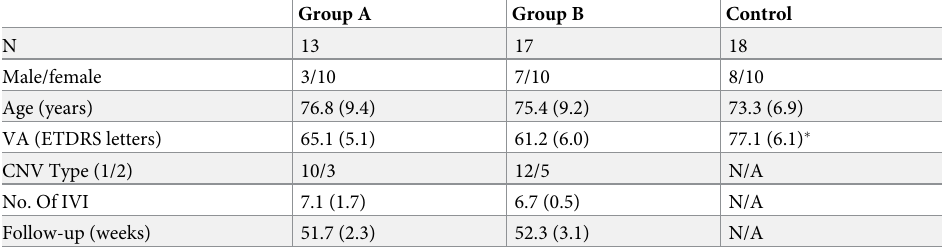
Table 1. Demographic and clinical data of patients under different antiVEGF therapy and the control group. Data are shown as mean